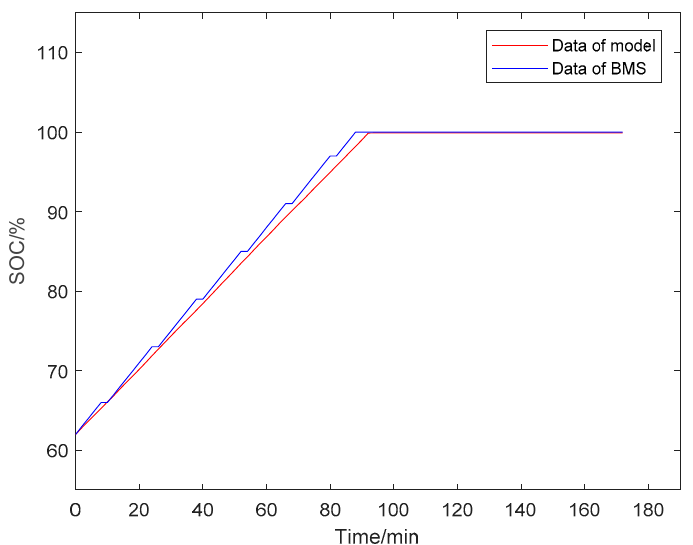
Figure 13. Comparison of SOC calculation data of battery model with SOC data provided by BMS.